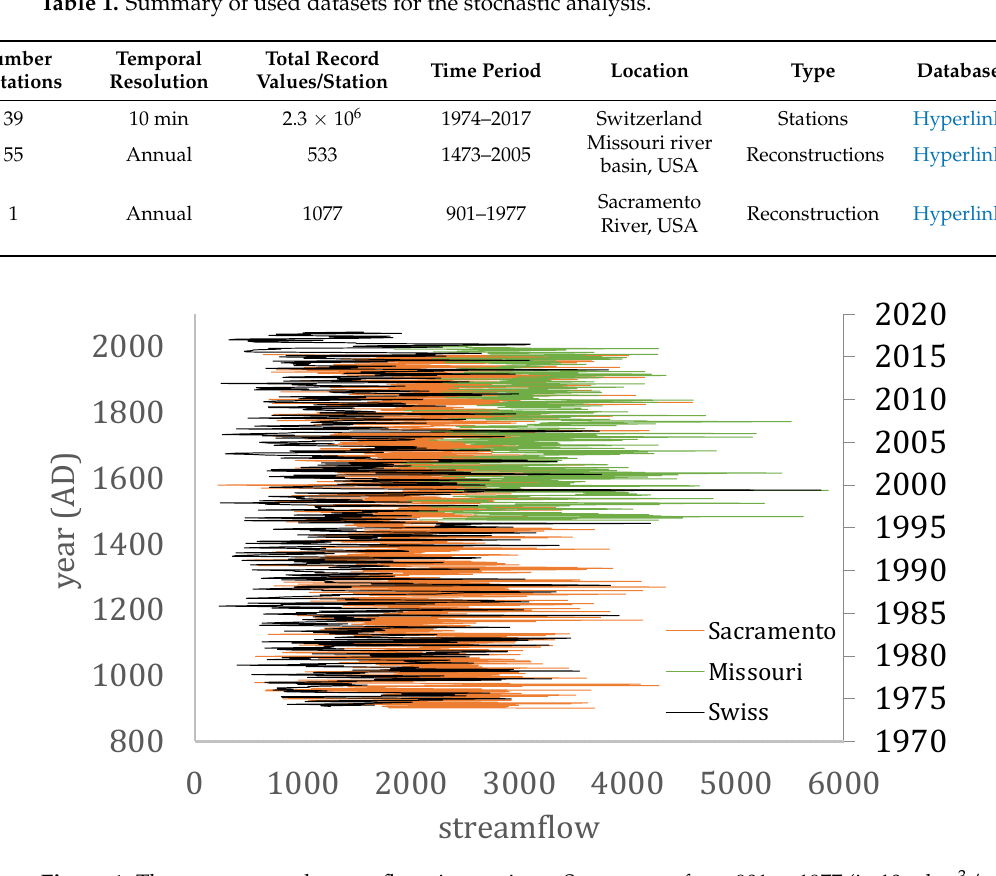
Table 1. Summary of used datasets for the stochastic analysis.